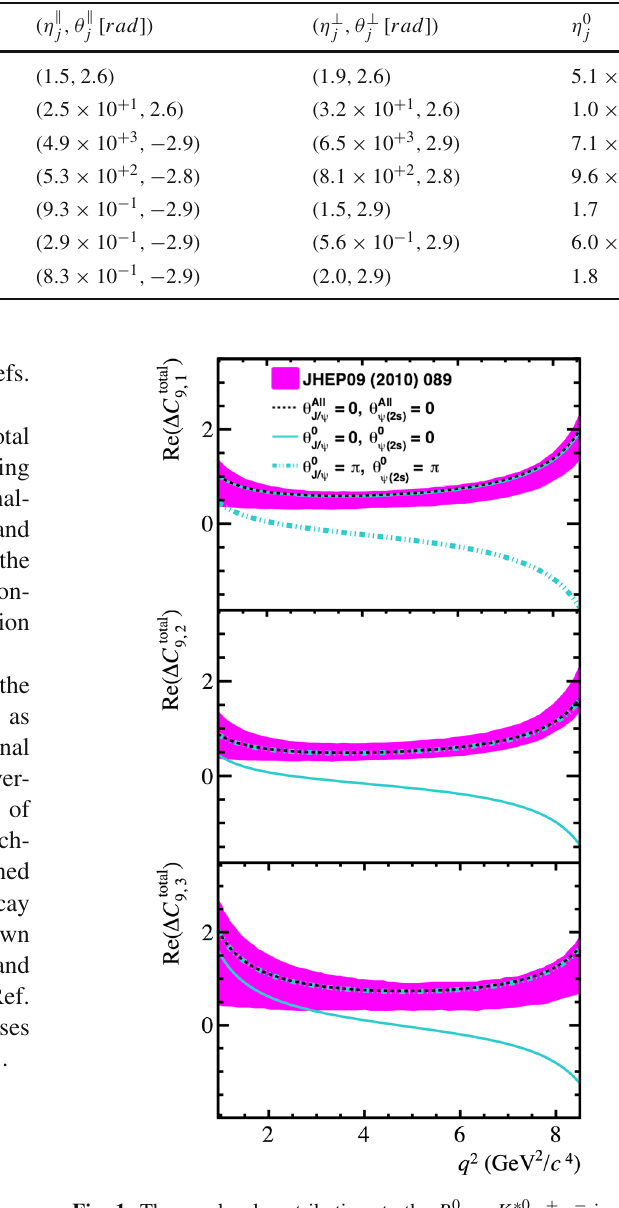
and θ 0 ψ( J /ψ 2 S )